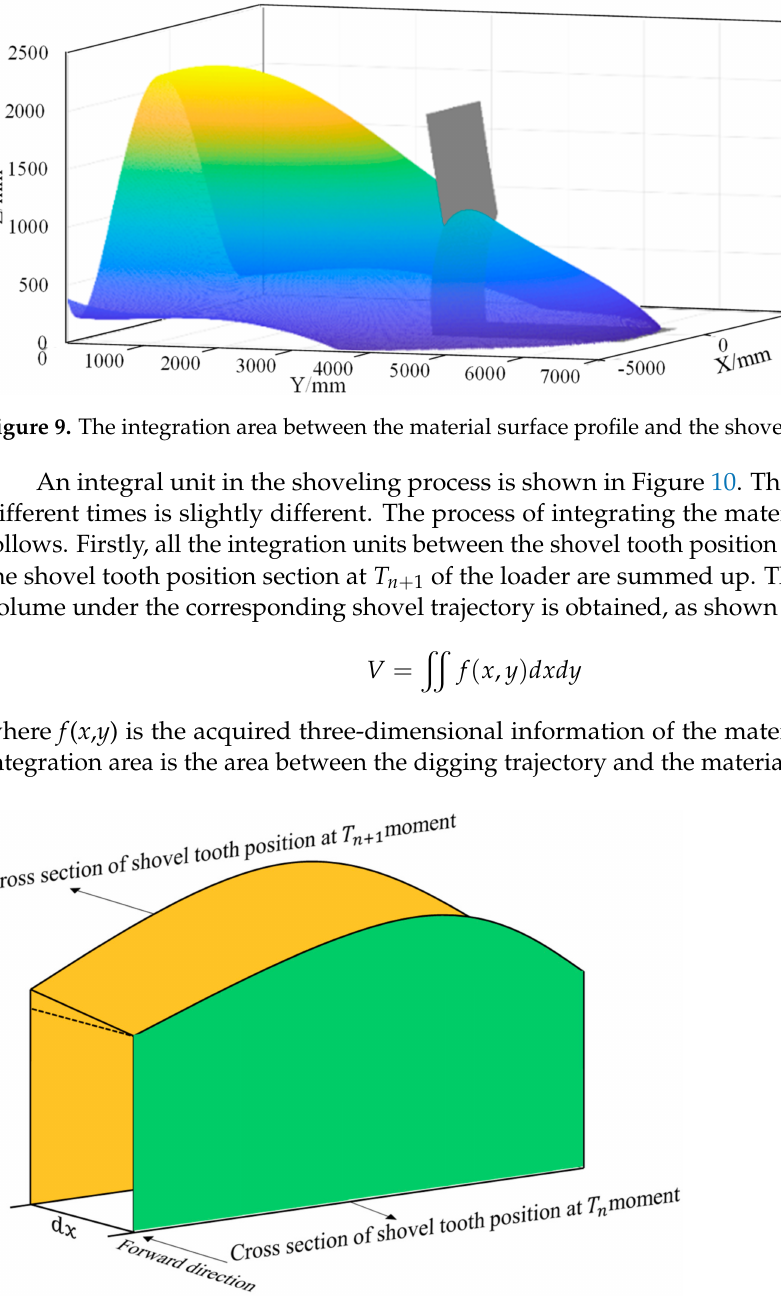
Figure 10. A volume integration